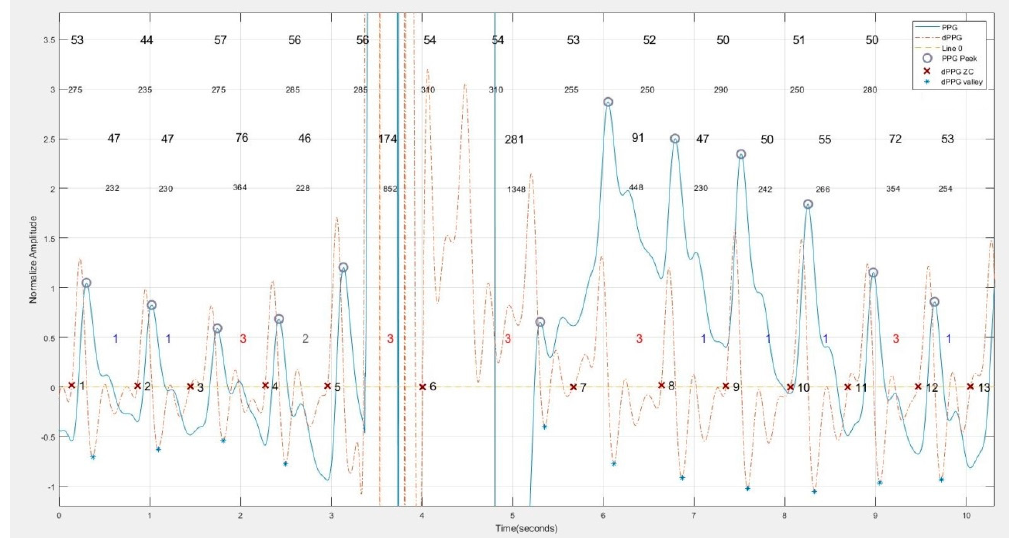
Figure 10. The PPG signal (solid line) and its differential signal (dashed line) for Subject 6, and his SVs and LVET measured by the medis ® CS 2000 and our ICG device.